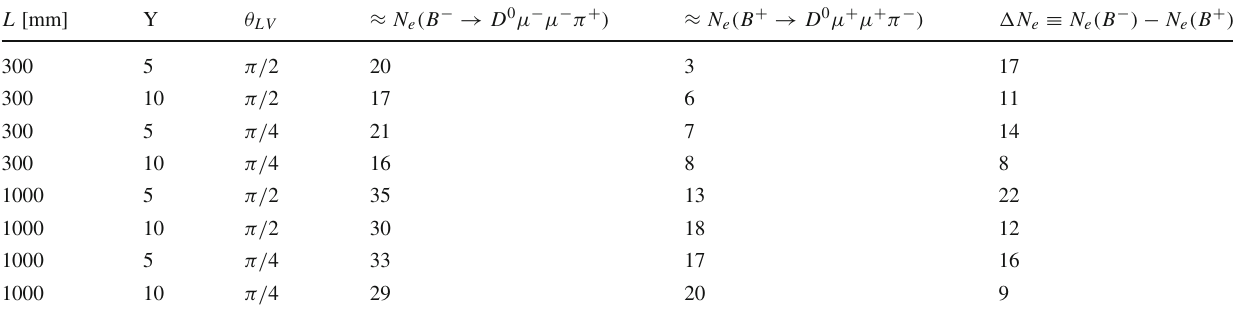
Table 1 Expected events at Belle II experiment. Here | B μ N | 2 = | B τ N | 2 = 10 − 5 and M N = 2 GeV